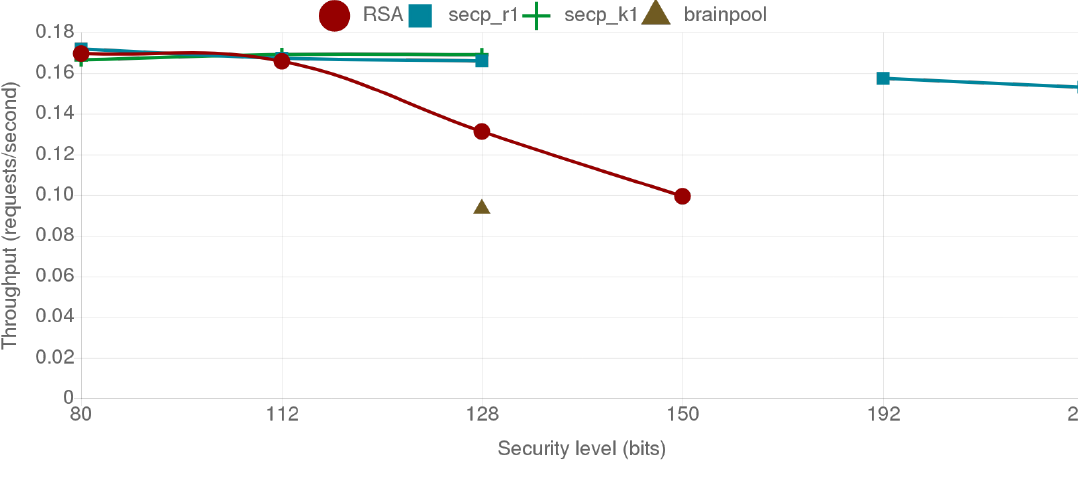
Figure 10. Throughput values in requests per second between both mist end devices. Table 4. Relevant TLS delays in mist end-device to mist end-device